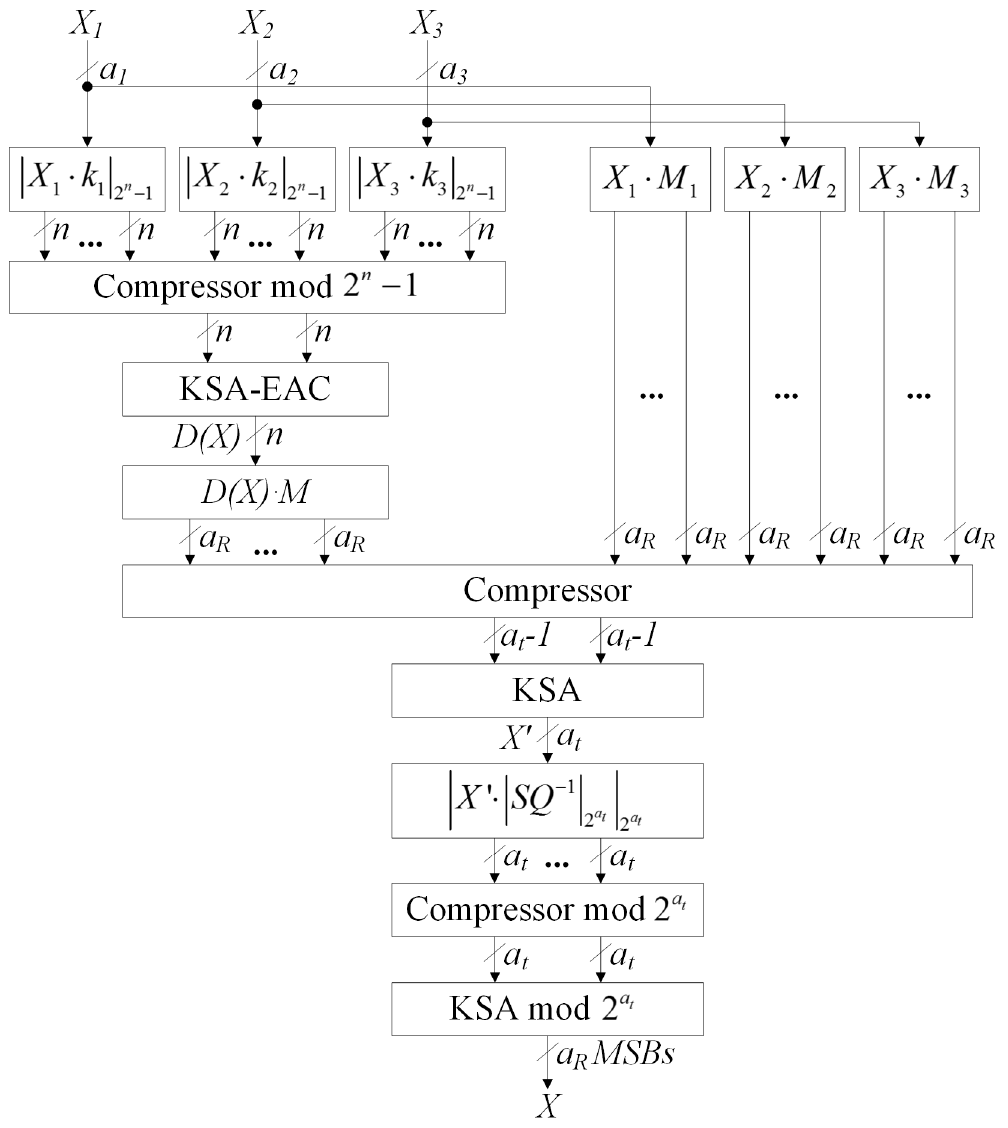
Figure 2. Reverse conversion circuit for the residue number system (RNS) with a DF of the form 2 1 n − .